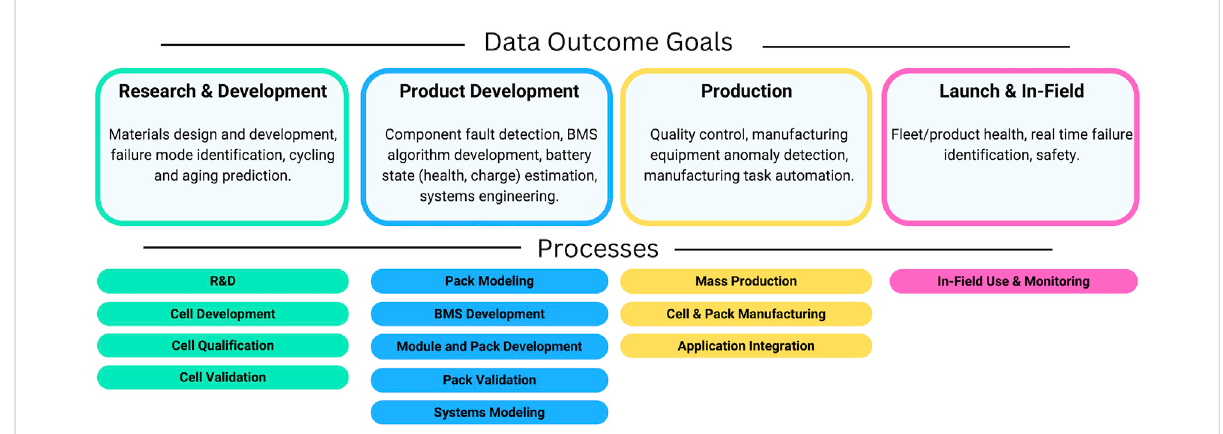
FIGURE 1 The four primary stages in the battery lifecycle, with experimental and data collection outcome goals described and processes in each phase listed below.